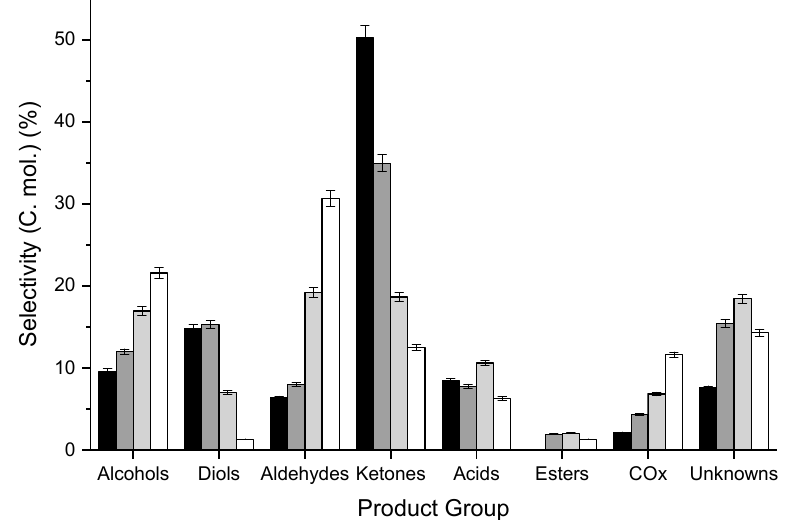
Figure 2. Influence of the reaction temperature on the product group selectivity at 320 ◦ C (black bar), 360 ◦ C (dark grey), 400 ◦ C (light grey) and 440 ◦ C (white bar). Reaction conditions; CeO 2 (8 m 2 g − 1 ) 1.5 g, GHSV 4154 h − 1 , 50 wt.% Gly/H 2 O, Ar 45 mL min − 1 .